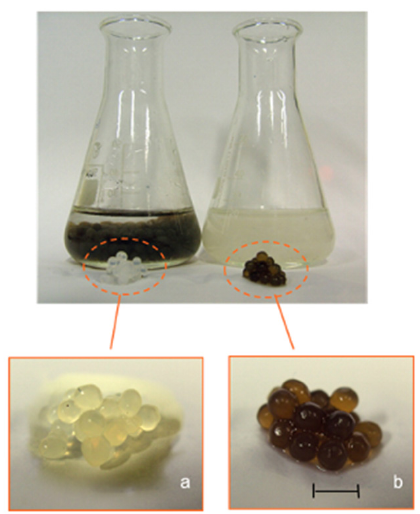
Figure A3. Images of ( a ) Ca-Alg and ( b ) Ca-Alg/GO wet gel beads. The scale bar = 0.5 cm.